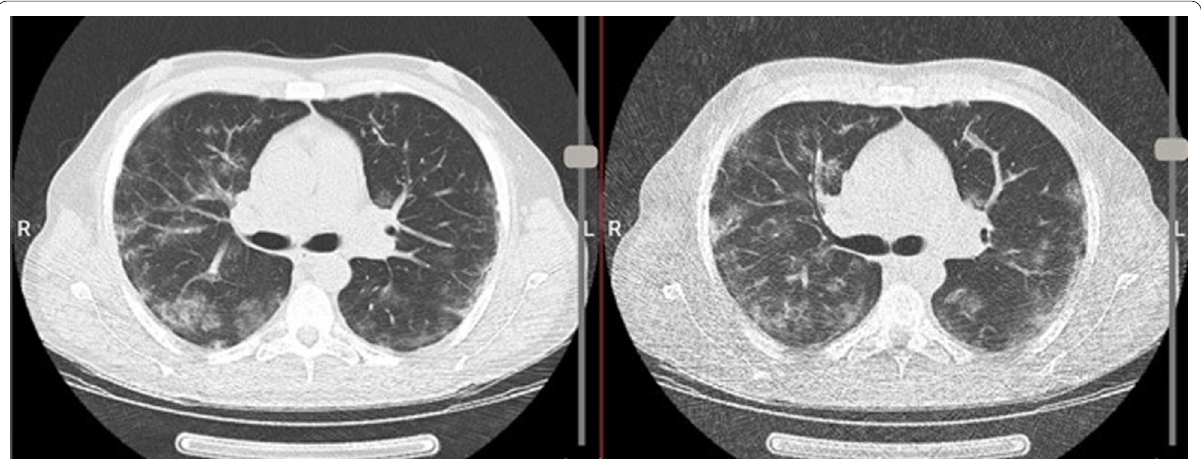
Fig. 1 Bilateral multifocal subpleural and peribronchovascular ground‑glass opacities in low‑dose (left image) and ultra‑low‑dose (right image) CT scans typical for COVID‑19